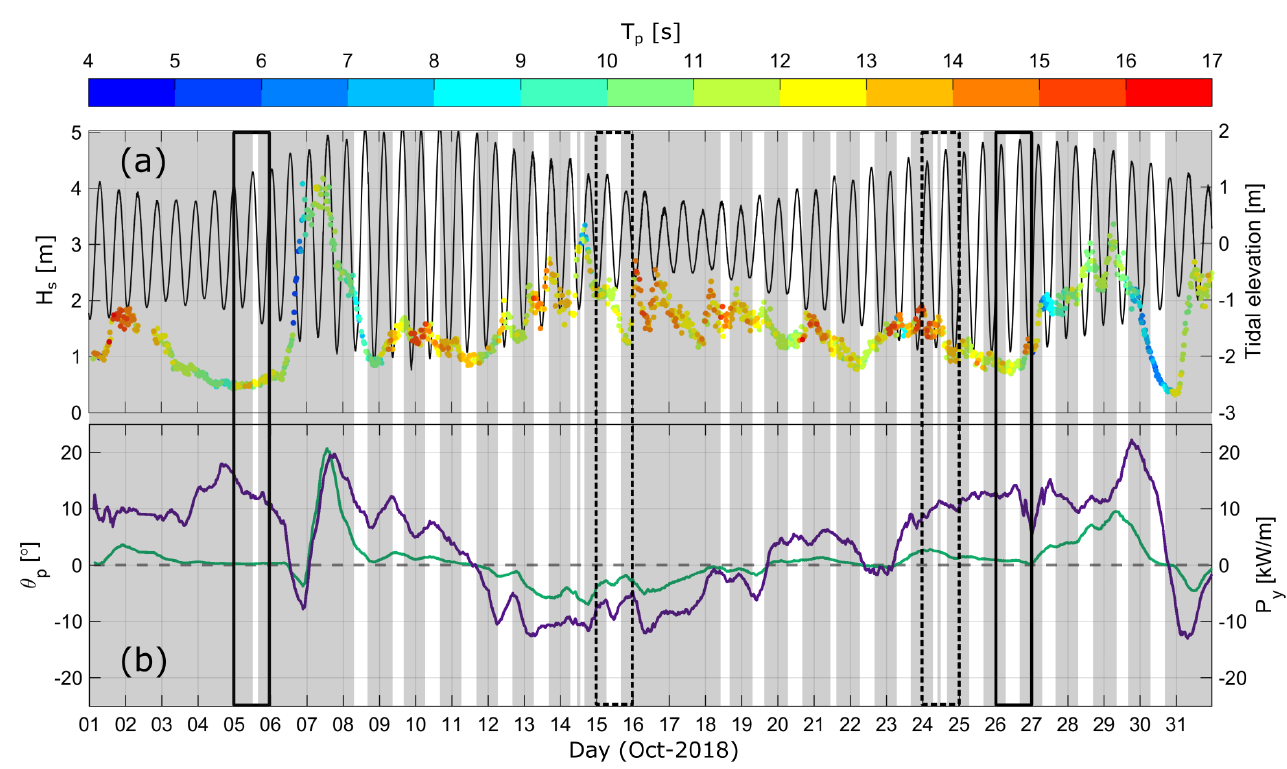
Figure 2. Field conditions during the October 2018 field experiment. ( a ) Tidal elevation (black line; see top right axis) and offshore significant wave height ( H s ; dots) time-series associated with offshore peak period ( T p ) depicted with different colors (top left axis). ( b ) Offshore 12 h averaged angle of peak wave incidence ( θ p ) relative to the shore normal (purple line; bottom left axis) and offshore 12 h averaged alongshore wave energy flux (green line; bottom right axis). Non-shaded regions in the time series indicate video recording during daylight hours. Polygons defined with black solid (dashed) lines show the time during bathymetric (topographic)